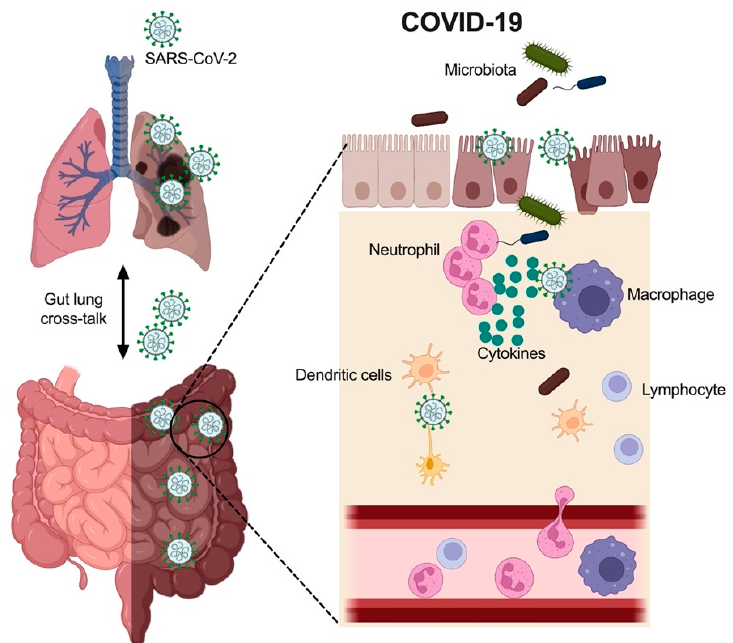
Figure 1. Clinical features of COVID-19-induced gut injury. SARS-CoV-2 infects respiratory system, and the virus translocate to gastrointestinal (GI) tract. This leads to immune cell recruitments in the gut, including neutrophils, macrophages, dendritic cells and lymphocytes. The infection also results in these immune cells to secrete cytokines and microbiota changes in the GI